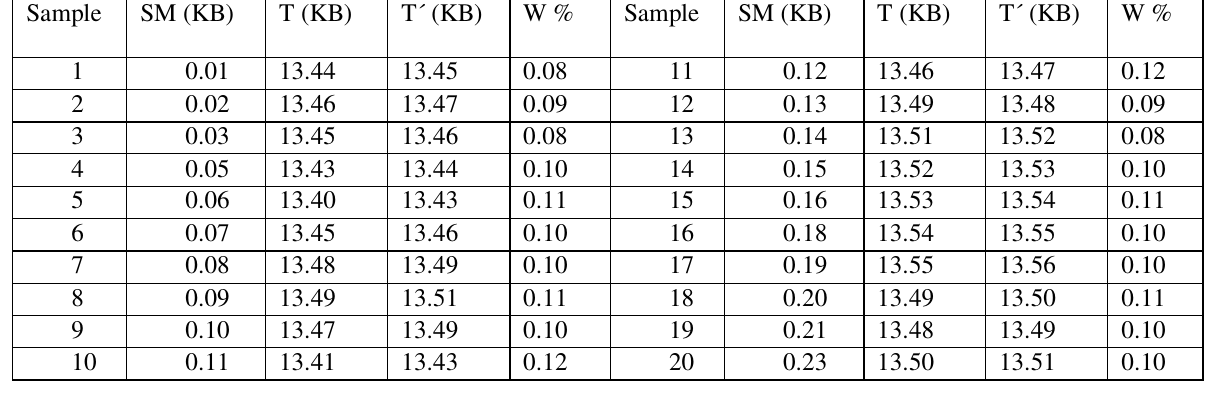
Table 2: Watermark embedding capacity and change in document size